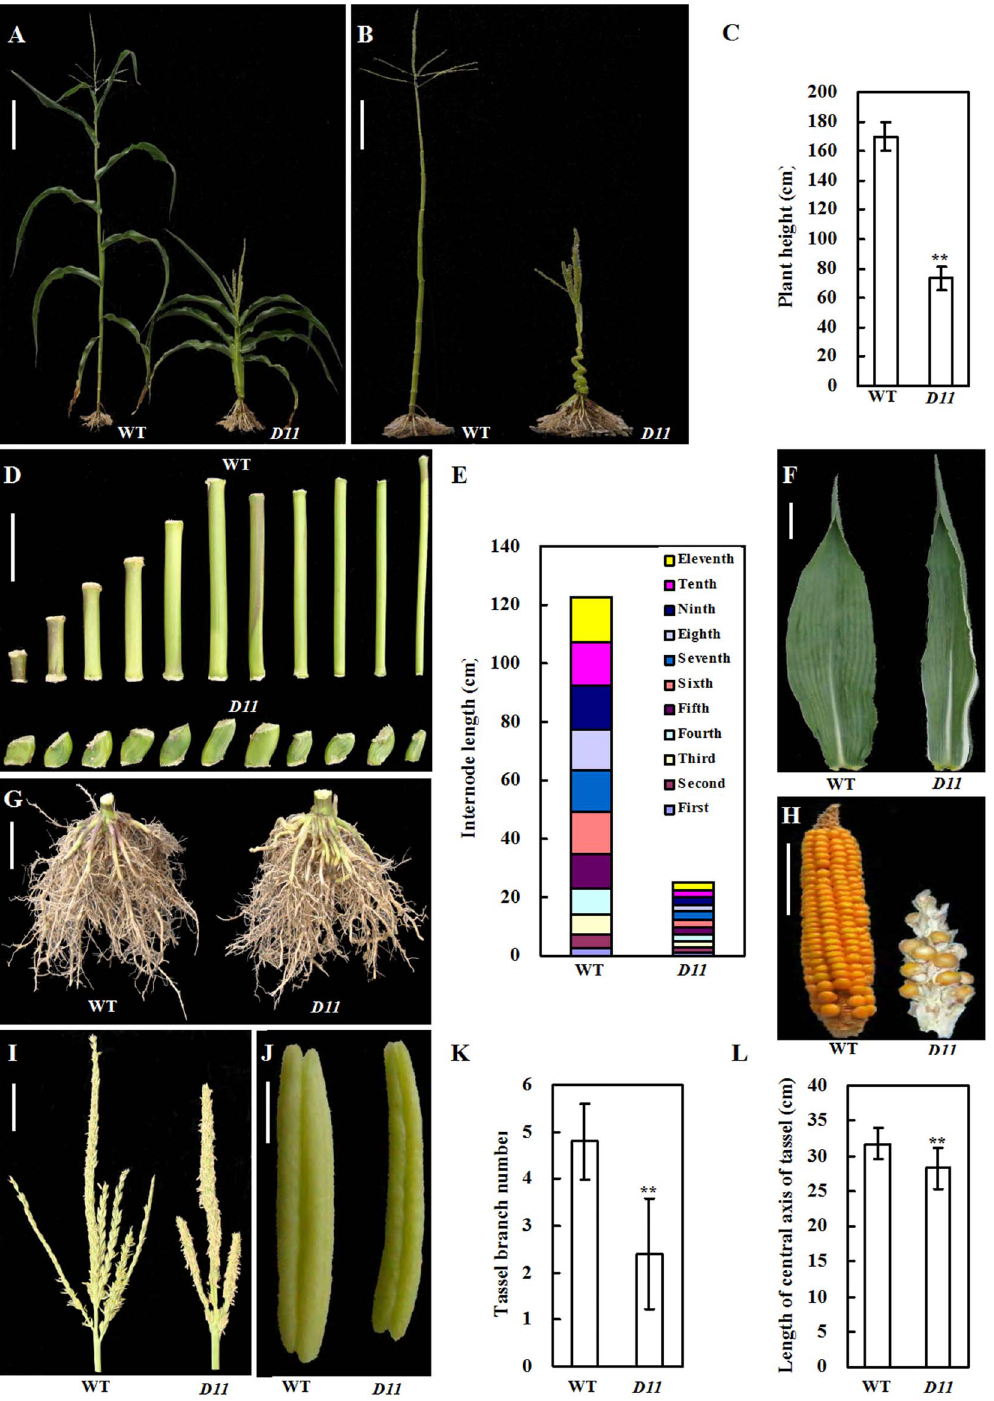
Figure 1. Gross morphology of maize D11 mutant. ( A ) Phenotype of D11 and wild type (WT). Bar =20 cm. ( B ) Whole plant. To get snapshot of internodes arrangement, leaves and spike were removed manually. Bar =20 cm. ( C ) Plant height. ( D ) Internodes. Bar =5 cm. ( E ) Internode length. ( F ) Leaf. Leaves of D11 are slender, dark green, slightly-rolled, and with white margins. Bar =5 cm. ( G ) Roots. Aerial roots of D11 display more sturdy. Bar =5 cm. ( H ) Spike. Spike of D11 degenerates severely. Bar =5 cm. ( I ) Tassel. Bar =5 cm. ( J ) Anther. Anthers of D11 are short and thin. Bar =1 mm. ( K ) Tassel branch number. ( L ) Length of central axis of tassel. In figures (C), (E), (K), and (L), data are mean 6 SD ( n =30). Double asterisks denote significant difference at P # 0.01 level compared with the wild type by Student’s t test.